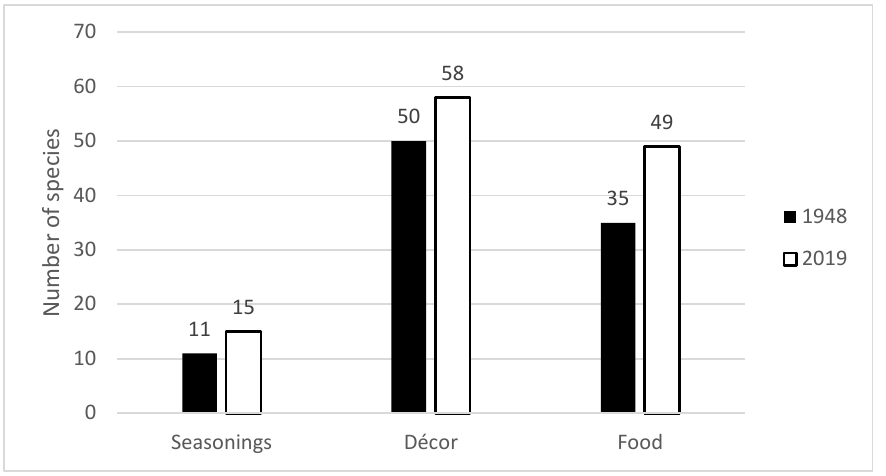
Figure 5. Other uses of herbal materials.